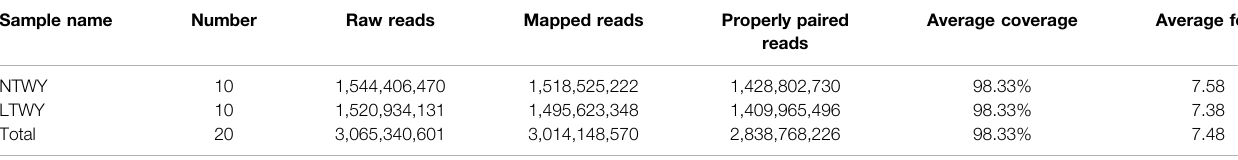
TABLE 1 | Summary statistics of NTWY and LTWY re-sequenced reads.